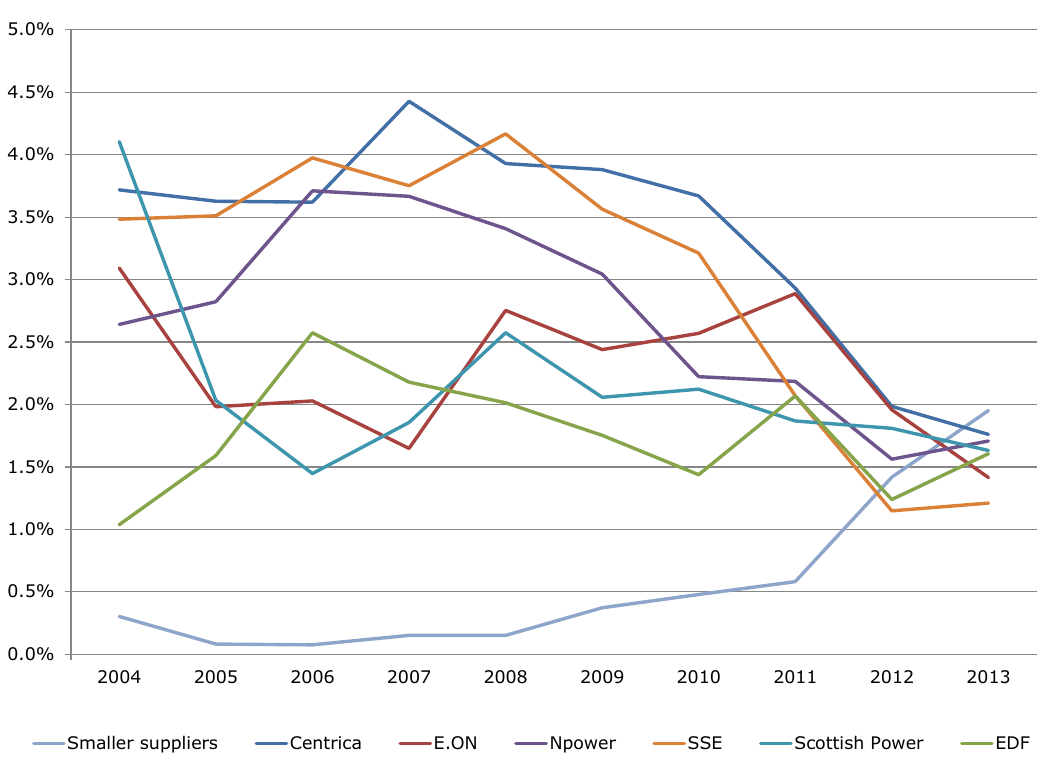
Figure 28: New gas customers as a proportion of all gas customers 2004